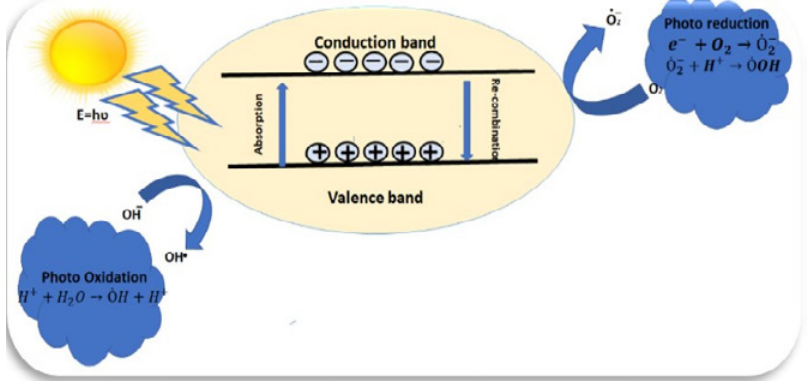
Fig.4. Schematic photodegradation mechanism of SnO